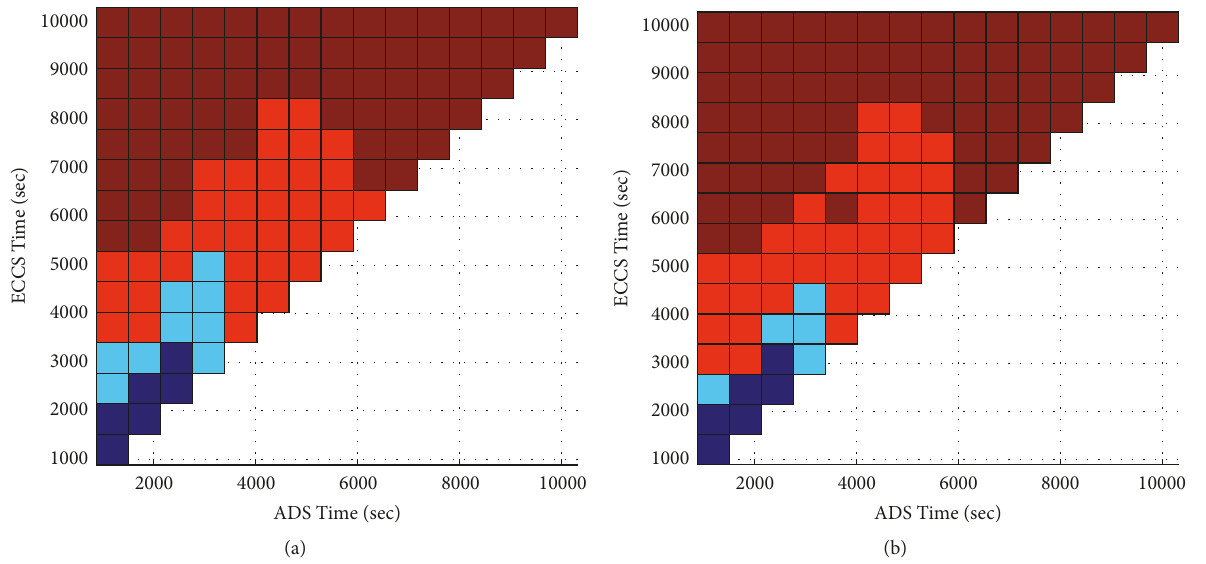
Figure 18: Fuel damage state (a) at the time of water injection (ECCS time) and (b) at the time of transition ( 𝑇 𝑡𝑟 ) as predicted by MELCOR 2.1 with Lipinski dryout model switched